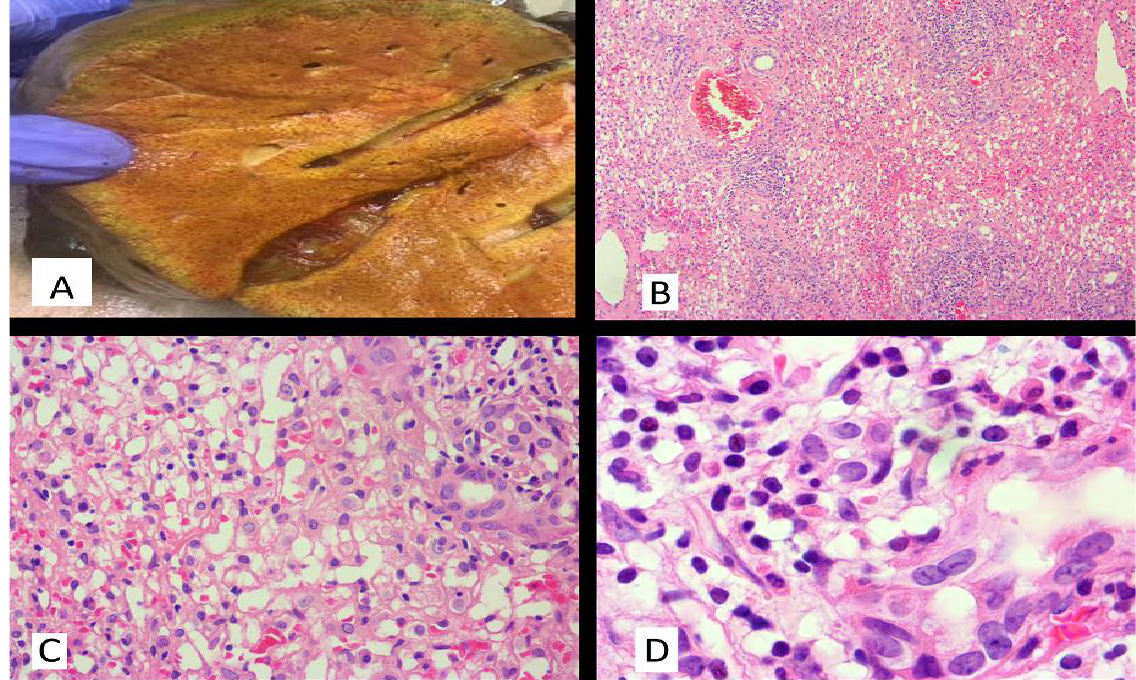
Fig 2. A. Mottled cut surface of the liver in gross examination. B. Confluent necrosis in the liver parenchyma (x100). C. Mild cholangiolar reaction as well as infiltration of mix population inflammatory cells is noted in portal tracts (x400). D. Prominent eosinophilic infiltration in the portal tracts